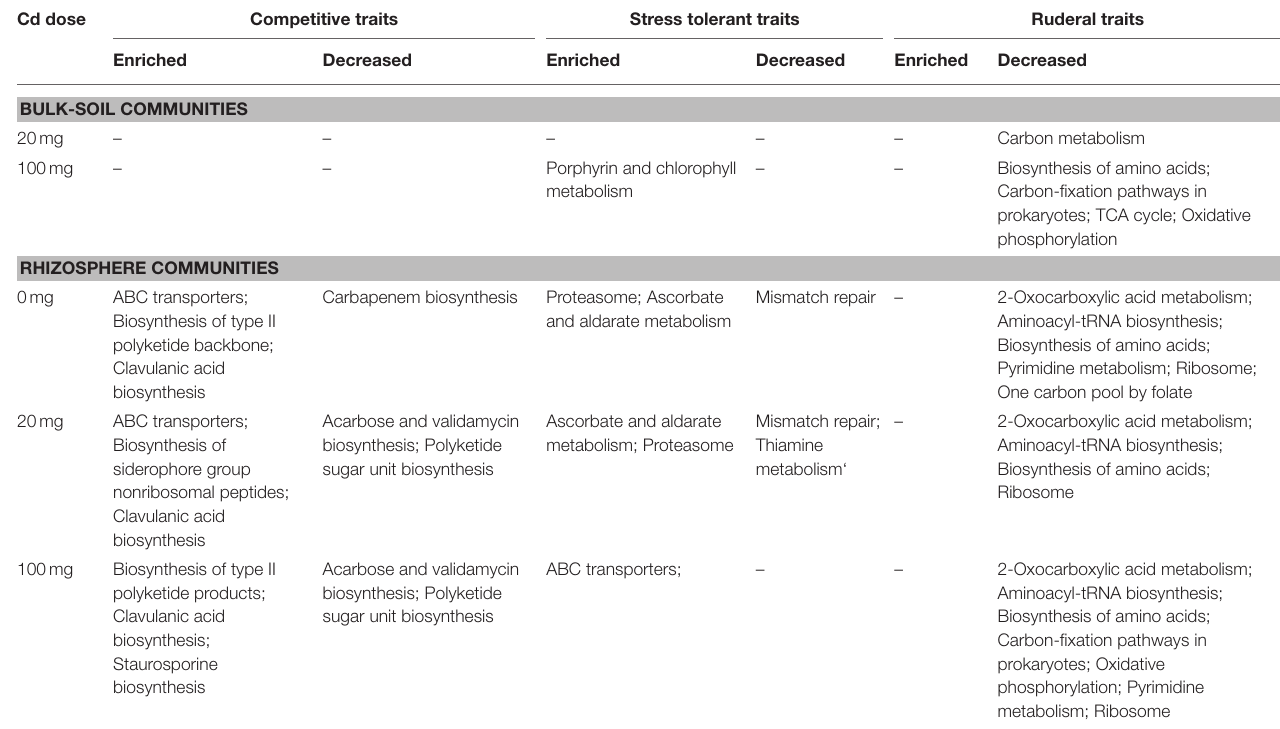
TABLE 2 | Functional pathways identified as relating to competition (C), stress-tolerance (S) or ruderal life strategies (R), and their patterns of enrichment for each microcosm relative to base-line communities from no-Cd bulk-soil treatments. Cd